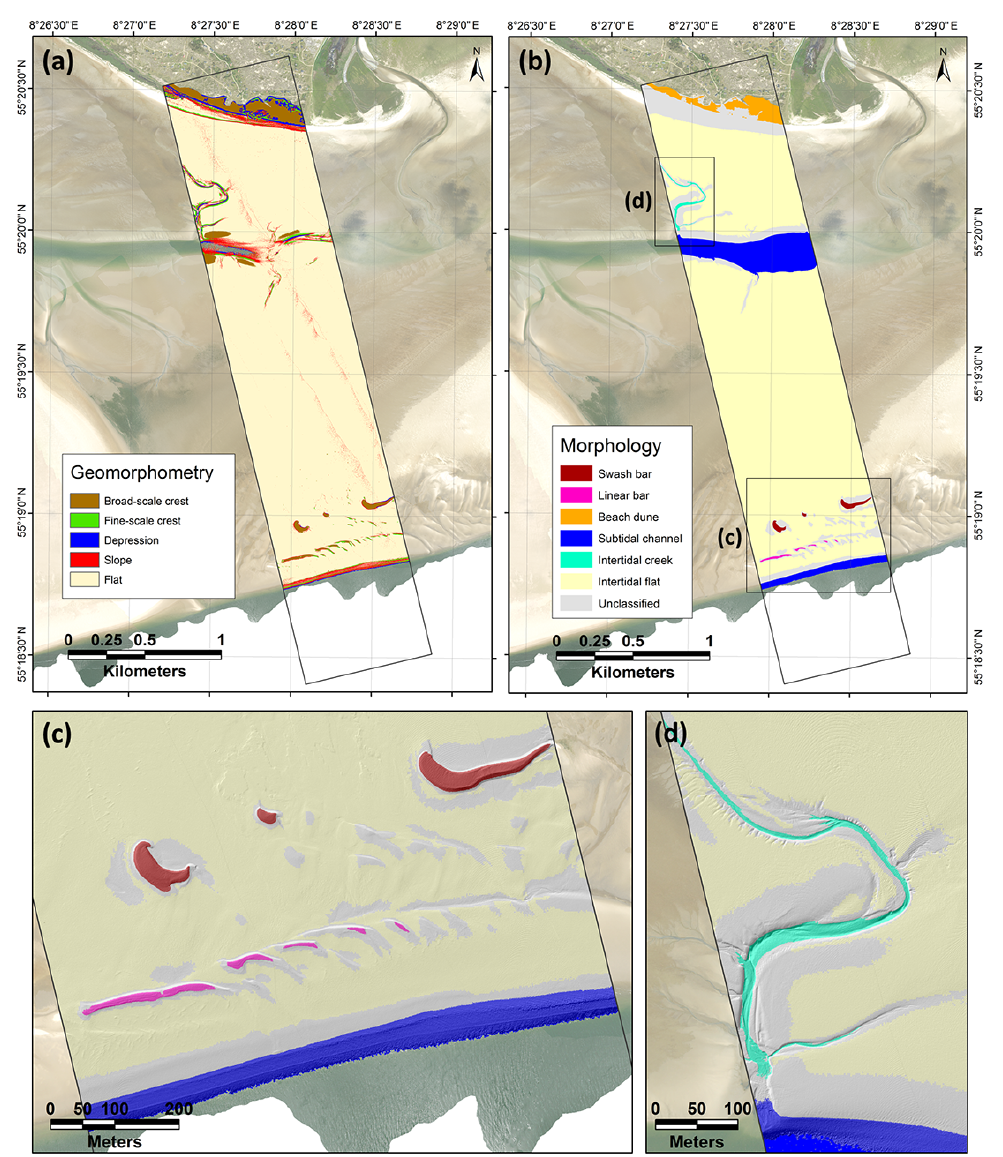
Figure 10. Two classifications derived from topobathymetric lidar data: (a) geomorphometric classification and (b) morphological classi- fication. Panel (c) indicates zoom-in on the swash bars and linear bars close to the main channel in the morphological classification and (d) zoom-in on the intertidal creek in the morphological classification. A hillshade of the DEM is draped over (c) and (d)